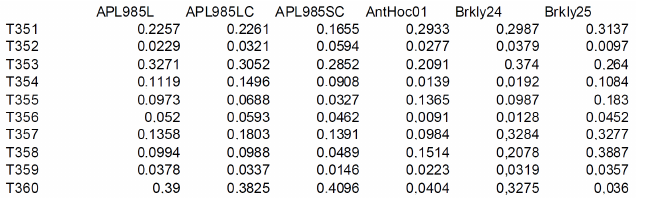
Figure 6. A 2D matrix representing the effectiveness of different systems (X axis) on different topics (Y axis). This matrix is an extract of the one representing the AP (effectiveness measure) for TREC 7 ad hoc participants on the topic set of that track.